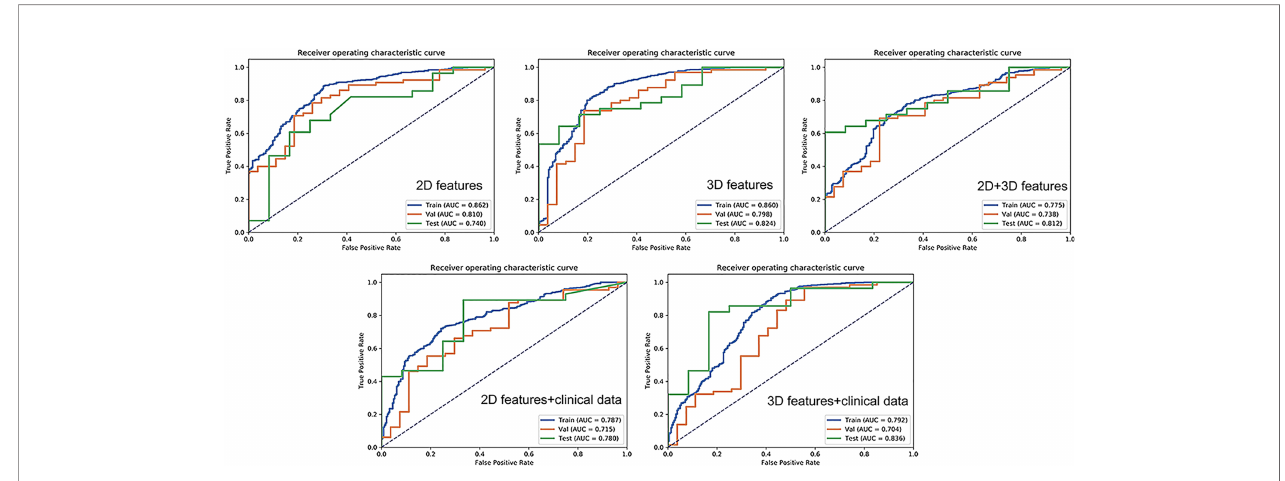
FIGURE 5 | Receiver operating characteristic curves for 2D features, 2D + clinical features, 2D + 3D features, 3D features, and 3D + clinical features in distinguishing malignant from benign solitary pulmonary lesions.